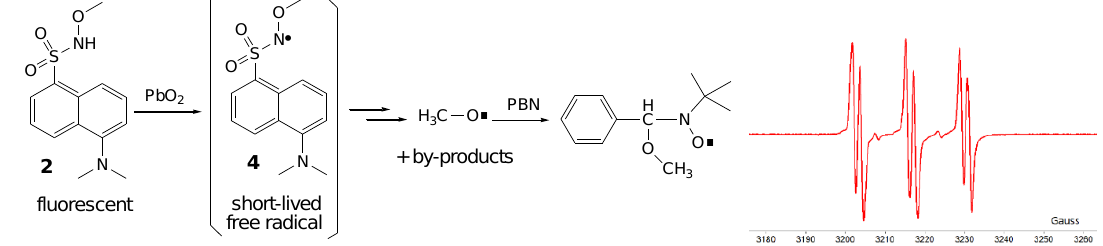
Figure 9. Oxidation of 2 and ESR spectrum of the spin-adduct.